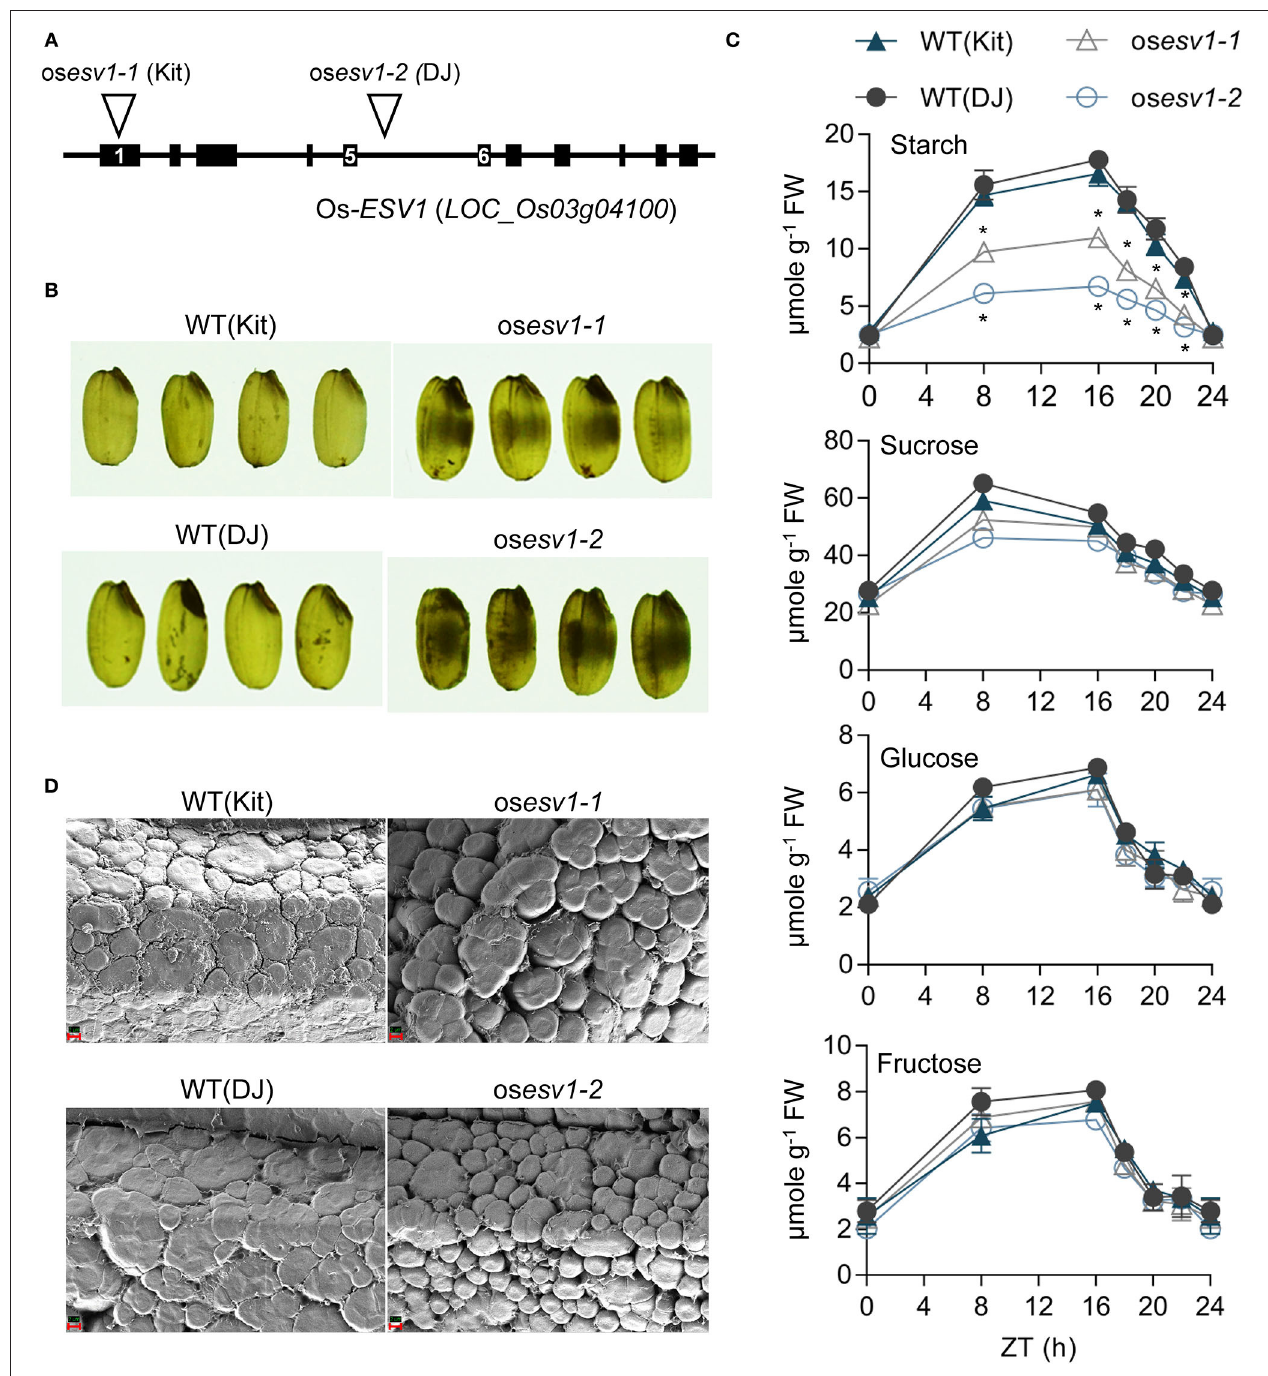
FIGURE 6 | Rice ESV1 promotes the accumulation of starch in leaves and the tight packing of starch granules in grains. (A) A diagram showing two rice ESV1 mutant alleles. Two rice T-DNA insertion lines (os ESV1-1, os ESV1-2 ) were isolated from the rice stock center. Kitaake (Kit) and Dongjin (DJ) in parenthesis are their respective wild type cultivars. Back bars: exons, Lines: introns, numbers in black bars: exon numbers, inverted triangle: T-DNA insertion locus. (B) Chalky grains of rice ESV1 mutants. Grain images were taken on a white light box. Black patches in the grains indicate chalky areas. (C) Reduced levels of starch but not soluble sugars in rice ESV1 mutant leaves. Leaves of 6-week-old rice plants grown under a 14/10 light/dark cycle in a greenhouse were sampled at each time point and the levels of glucose, fructose, sucrose, and starch were determined. Asterisks indicate significant differences from the respective wild type (* p < 0.05; Student’s t -test) ( Supplementary Table 1 ). Error bars = SEM ( n = 3 biological replicates). (D) SEM images showing loosely packed starch granules of fractured ESV1 mutant rice grains. Red scale bars appear in the lower left corners (2 µ m).